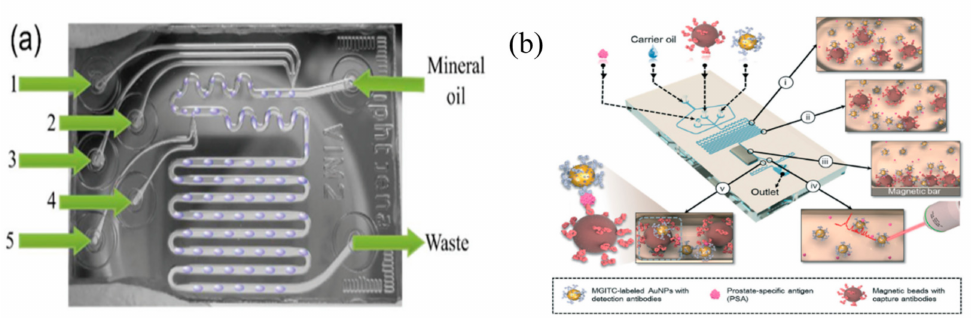
Figure 12. A typical microdroplet base SERS sensing platform: ports 1–5 are used for the injection of an aqueous solution containing the sample, the SERS active substrates, and their aggregation agent [126]; ( b ) Schematic illustration of the SERS-based microdroplet sensor for wash-free magnetic immunoassay. The sensor is composed of five compartments with the following functions: (i) droplet generation and reagent mixing; (ii) formation of magnetic immunocomplexes; (iii) magnetic barmediated isolation of immunocomplexes; (iv) generation of larger droplets containing the supernatant for SERS detection and (v) generation of smaller droplets containing magnetic immunocomplexes